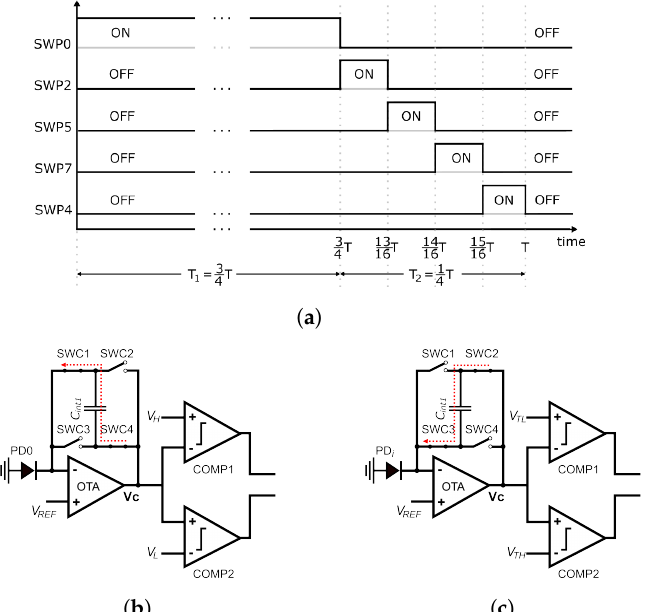
Figure 4. Input-select switch states and equivalent circuits for defective pixel detection during Phases 1 and 2 of circuit operation. The output logic stage is omitted for clarity. ( a ) Input-select switch states during Phases 1 and 2. ( b ) Equivalent circuit during Phase 1. ( c ) Equivalent circuit during Phase 2. In ( c ), PD i alternates between PD2, PD5, PD7, and PD4 during Phase